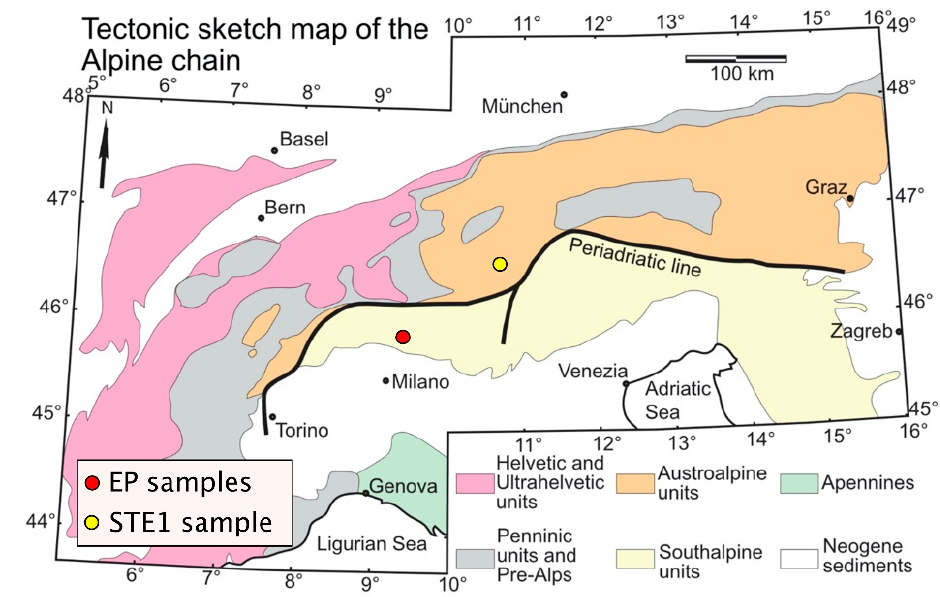
Figure 1. Tectonic map of the Alps showing the main geological domains and the locations where the analyzed samples were collected.